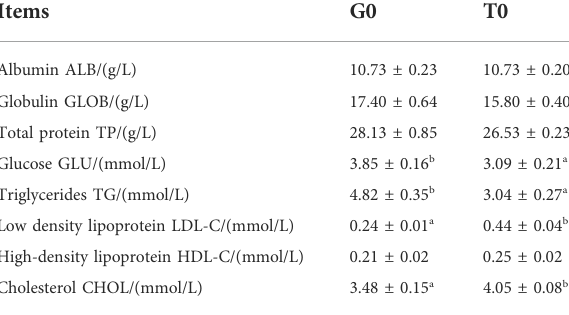
TABLE 2 Serum biochemical index of G0 group and T0 group ( n =